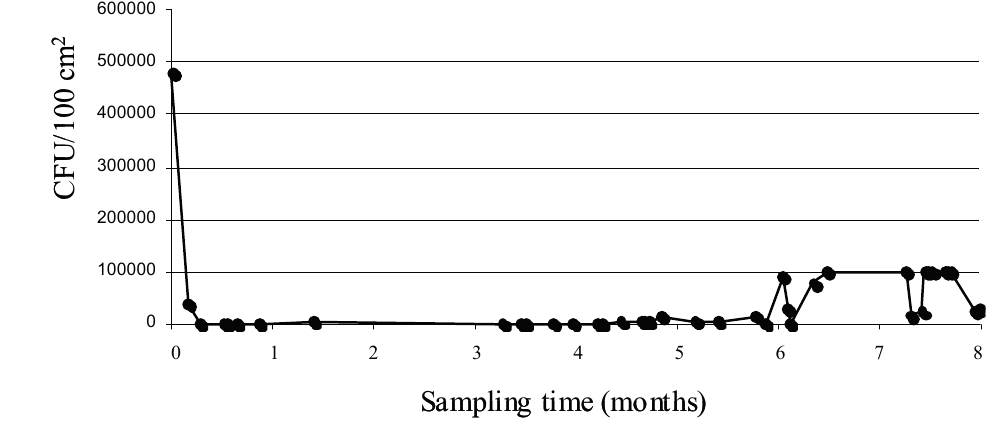
Figure 2. Eight-month total mesophilic aerobes counts trend for raw meat chopping board CFU Colony Forming